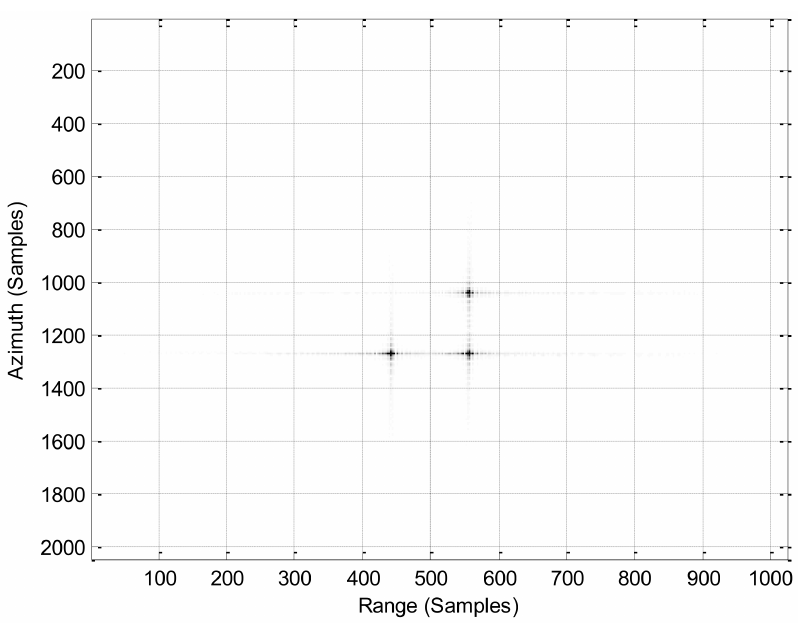
Figure 15. Azimuth-compressed SAR image by the proposed SAR